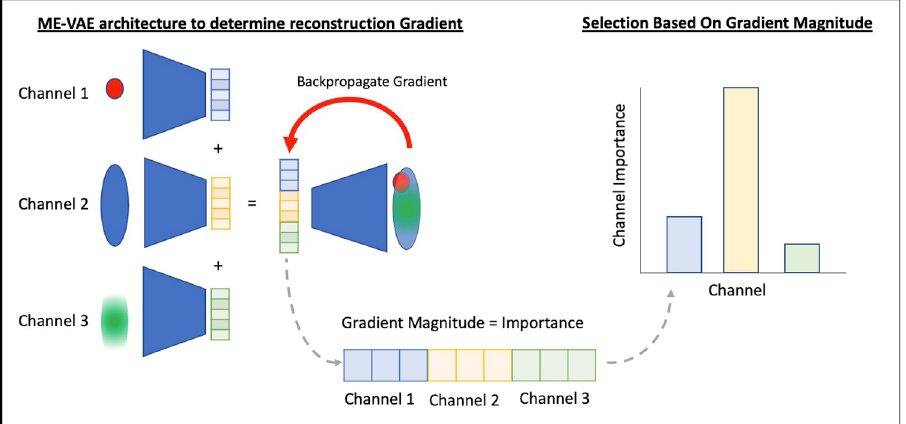
Fig 9. A multi encoder variational autoencoder architecture is implemented with each channel being used as the input to parallel encoders. The encodings of each channel are concatenated and decoded into a full panel image. The gradients of the model are then backpropagated to the encoding layer. If the magnitude of the gradient is interpreted as importance, the channel gradients can be averaged across the dataset to determine which markers are most important for reconstructing image features within the